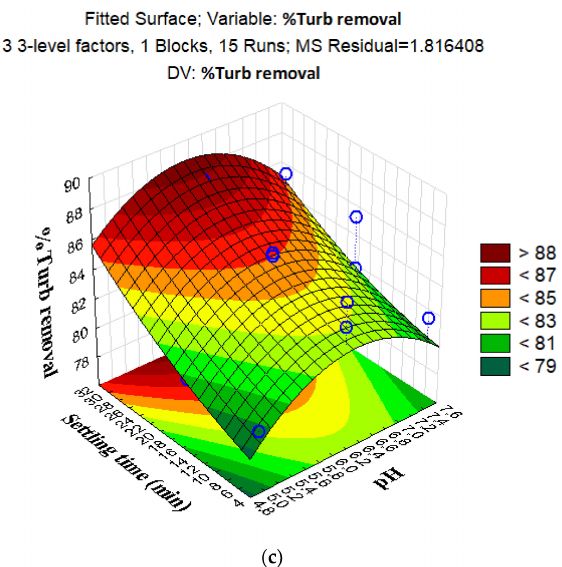
Figure 6. ( a ) Predicted and desirable % turbidity removal using chitosan from carapace of M. rosenbergii . ( b ) Pareto chart for standardized effects of the independent factors and interactions for % turbidity removal using chitosan from carapace of M. rosenbergii . ( c ) Three-dimensional fitted surface plots of % turbidity removal using chitosan from carapace of M. rosenbergii